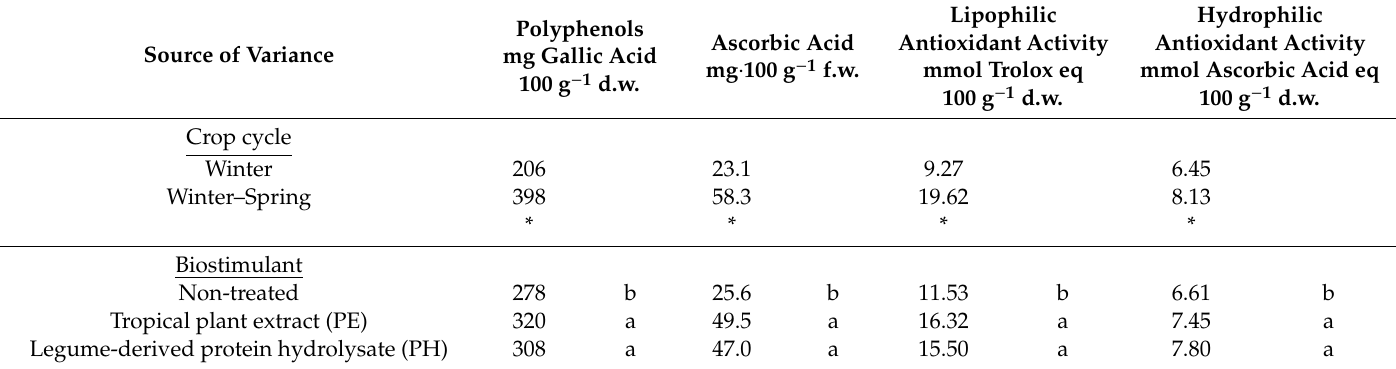
Table 5. Mean values of antioxidant content and activity of perennial wall rocket leaves as a ff ected by crop cycle and